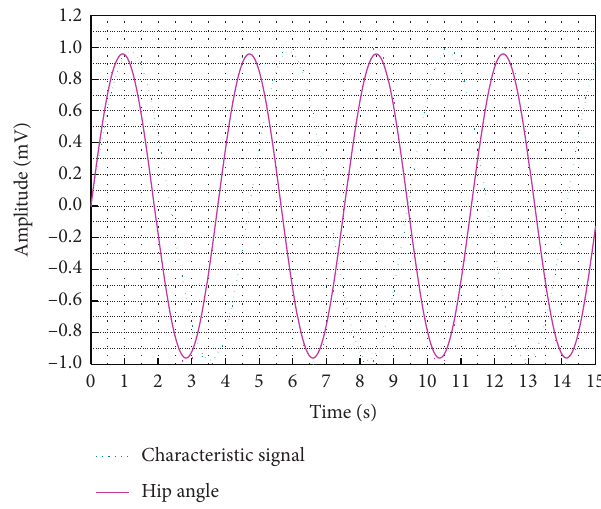
Figure 7: EMG signatures and hip angle.